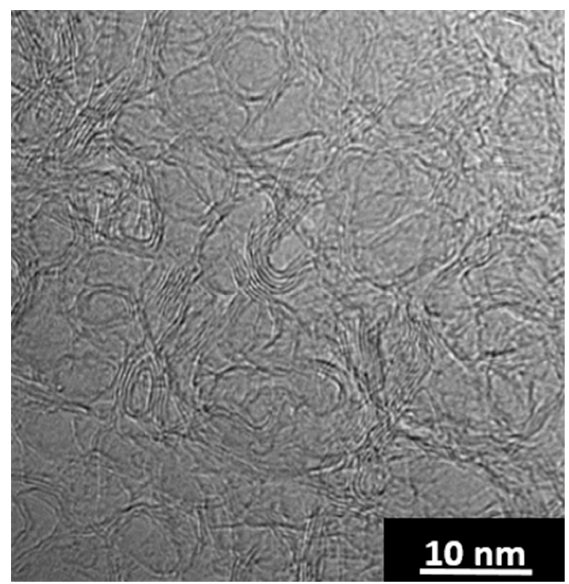
Figure 16. TEM micrograph of sucrose char after 5 s at 2600 °C.